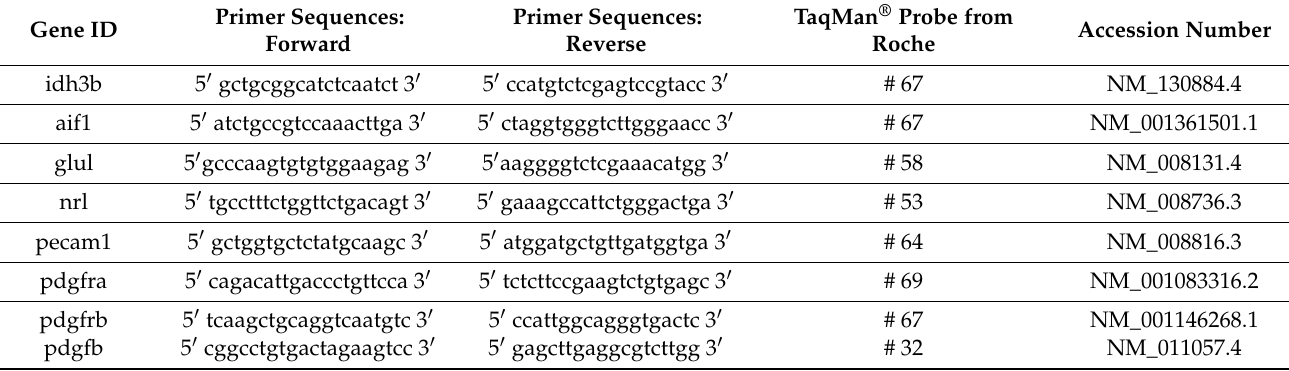
Table 1. Primer and TaqMan probe combinations for detection of the respective mRNA via